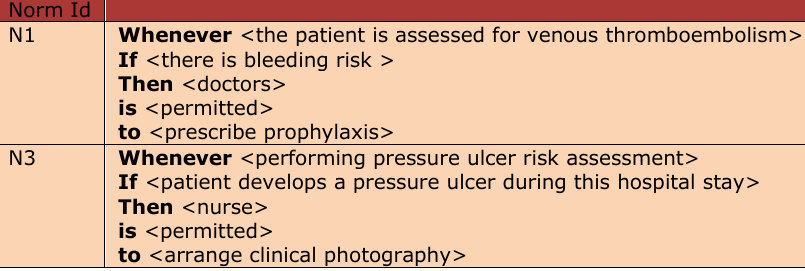
Table 1. Norm analysis for major gynecology care surgery